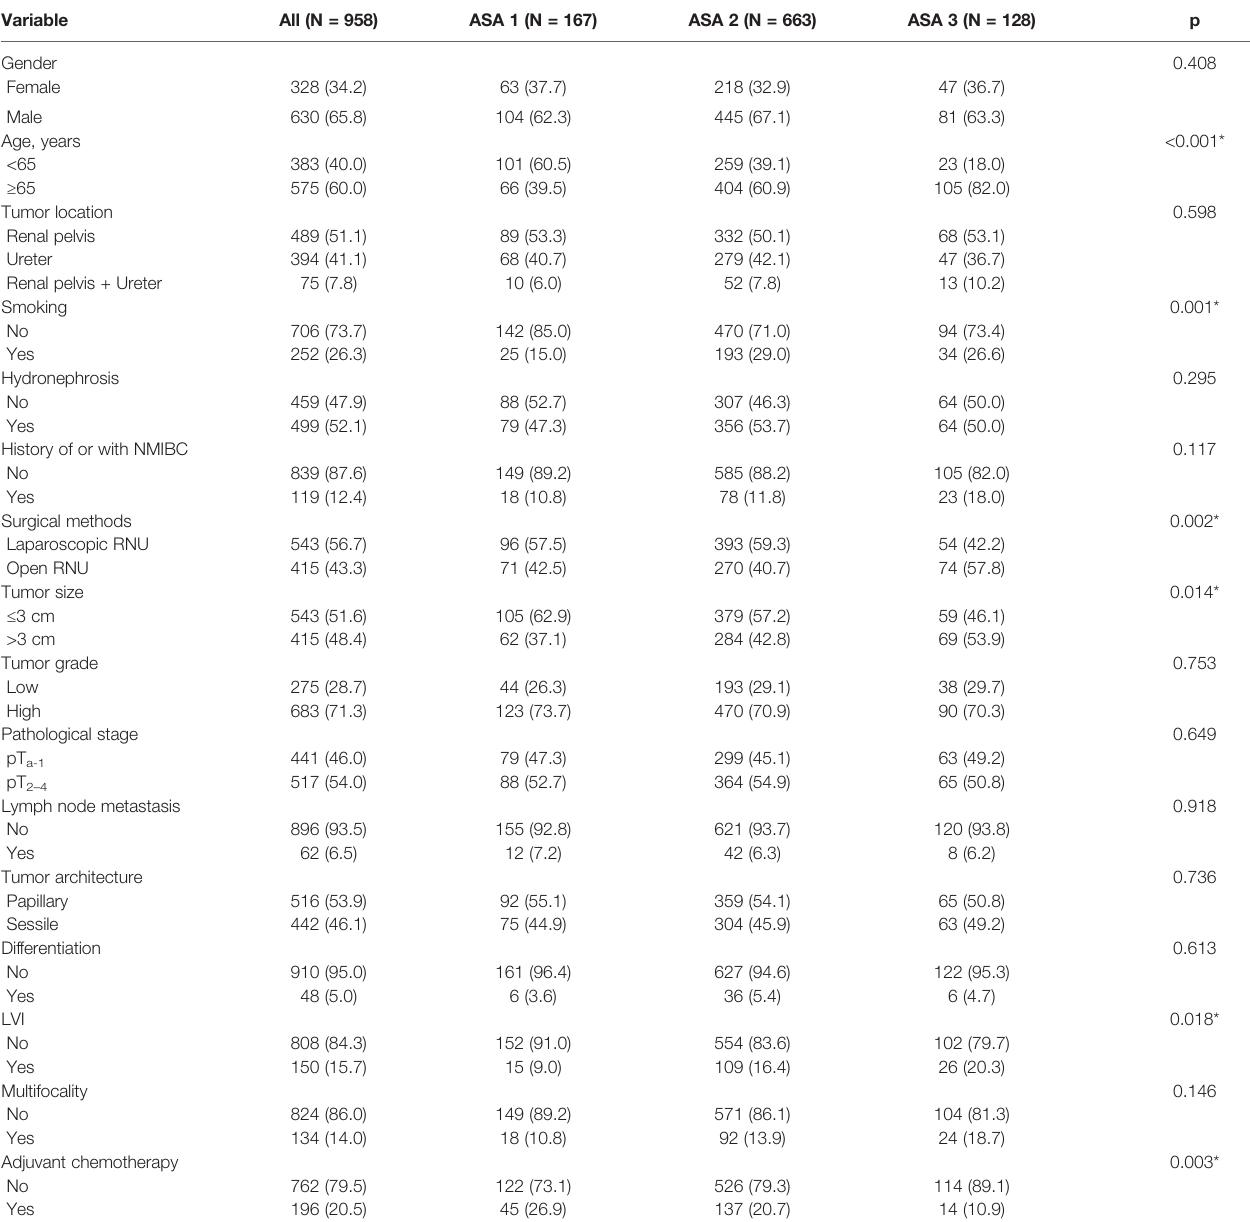
TABLE 2 | Clinicopathological characteristics of UTUC patients strati fi ed by ASA